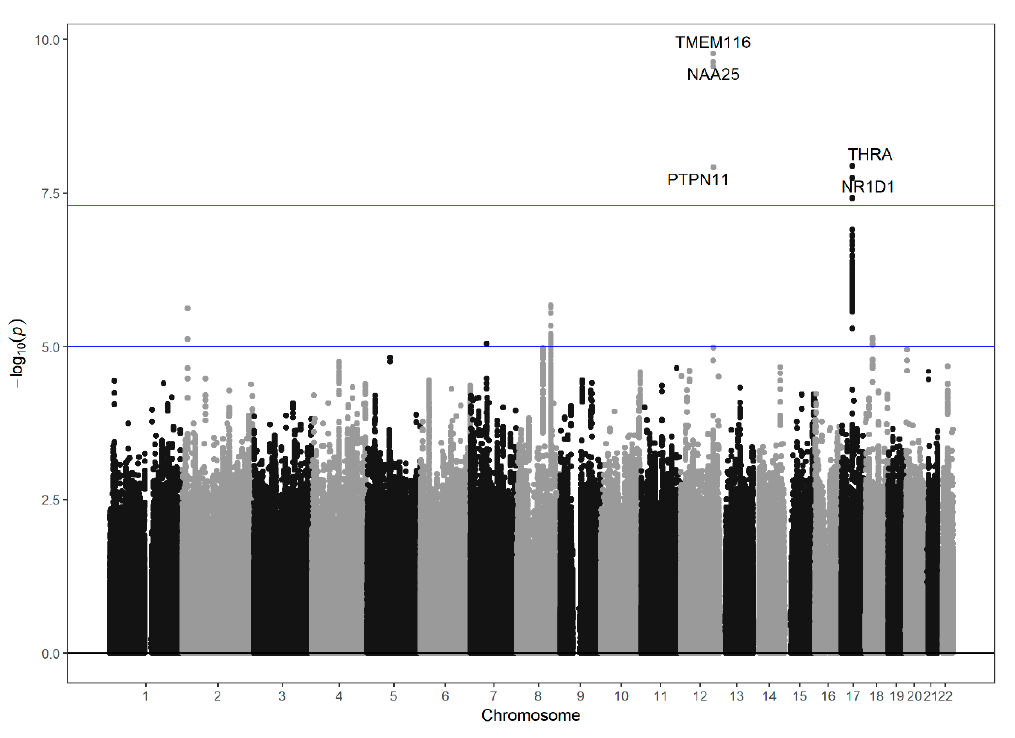
Figure 1. Manhattan plot of the strength of association [ − log10 ( P ) values; Y axis] between single-nucleotide polymorphisms (SNPs) (X-axis by chromosome and chromosomal position) and log-transformed NLR levels. Threshold line: 5 × 10 − 8 .